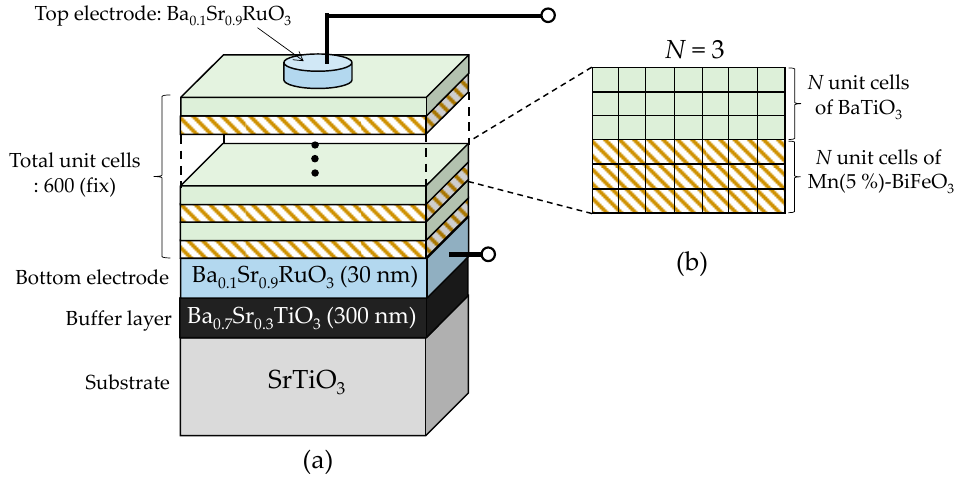
Figure 1. Schematics of the superlattice-structured thin film composed of layers of Mn(5%)-doped BiFeO 3 and BaTiO 3 . The total thickness of the superlattice is fixed at 600 ABO 3 unit cells ( a ), and the number ( N ) of ABO 3 in the two layers varies from 300 to 1, see ( b ) for N = 3.